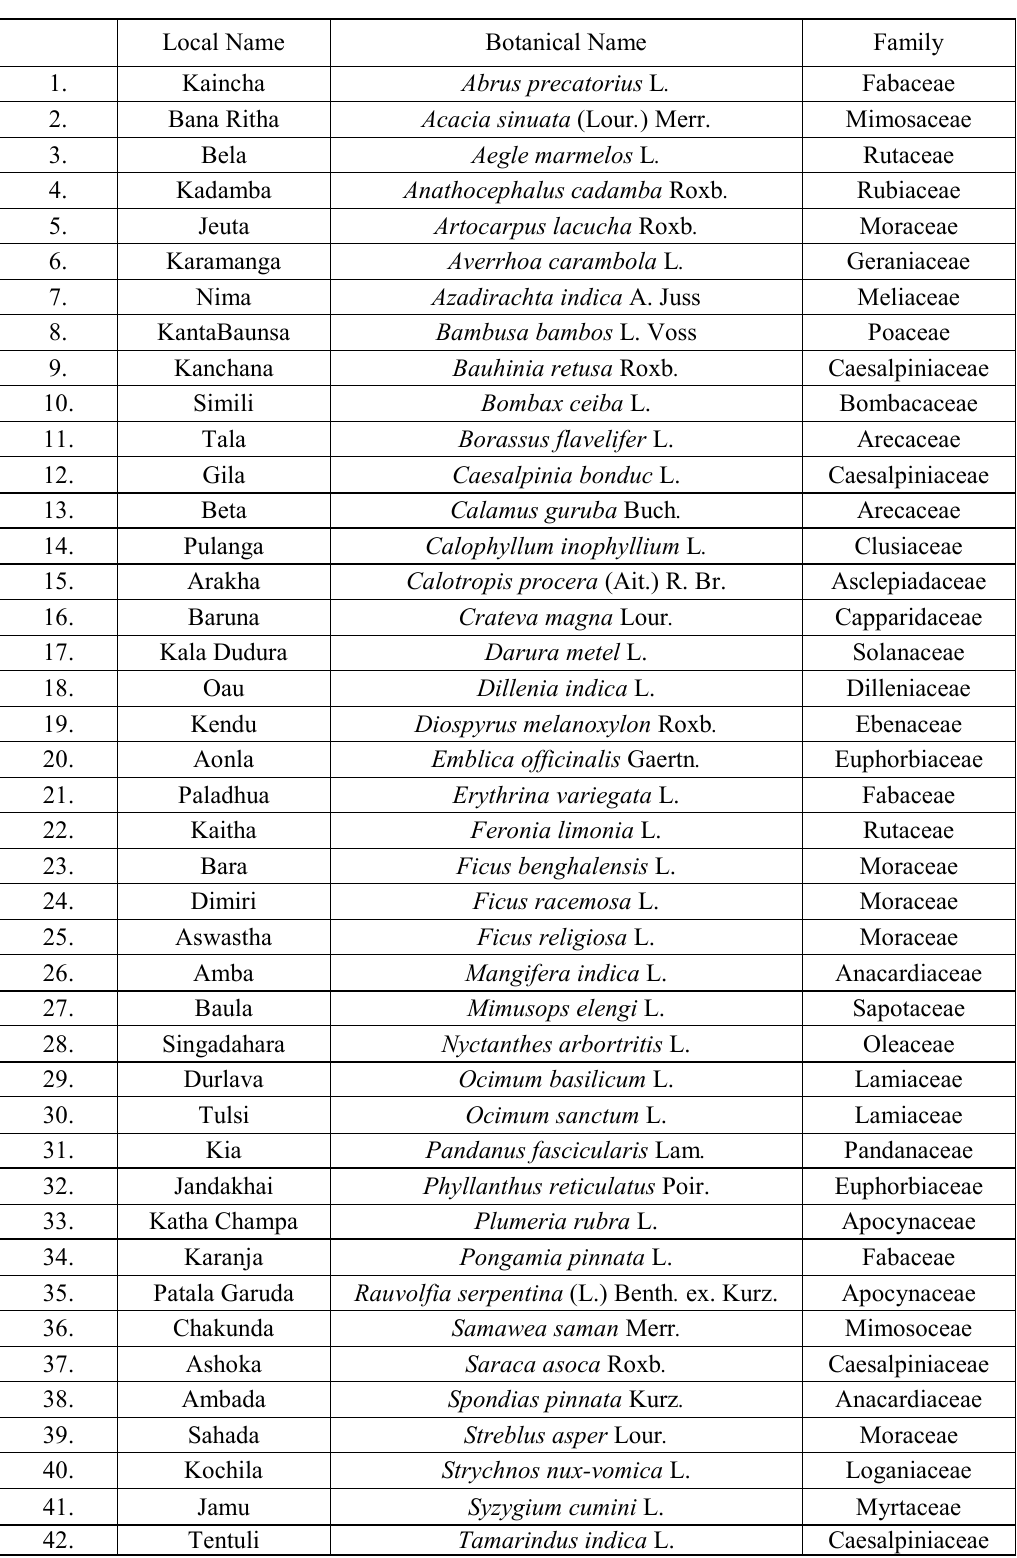
Table1. Plant species recorded from selected sacred groves of Bhadrak district,